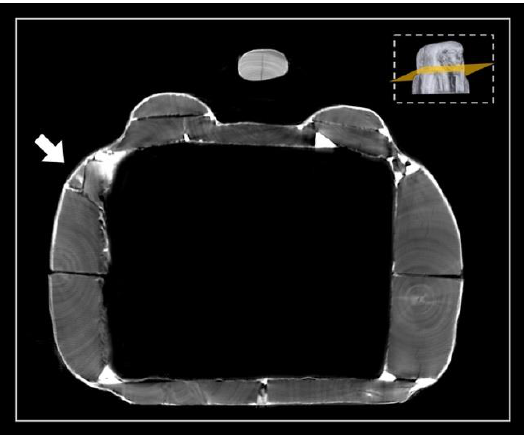
Figure 8. Axial slice showing the small insert with a triangular section.